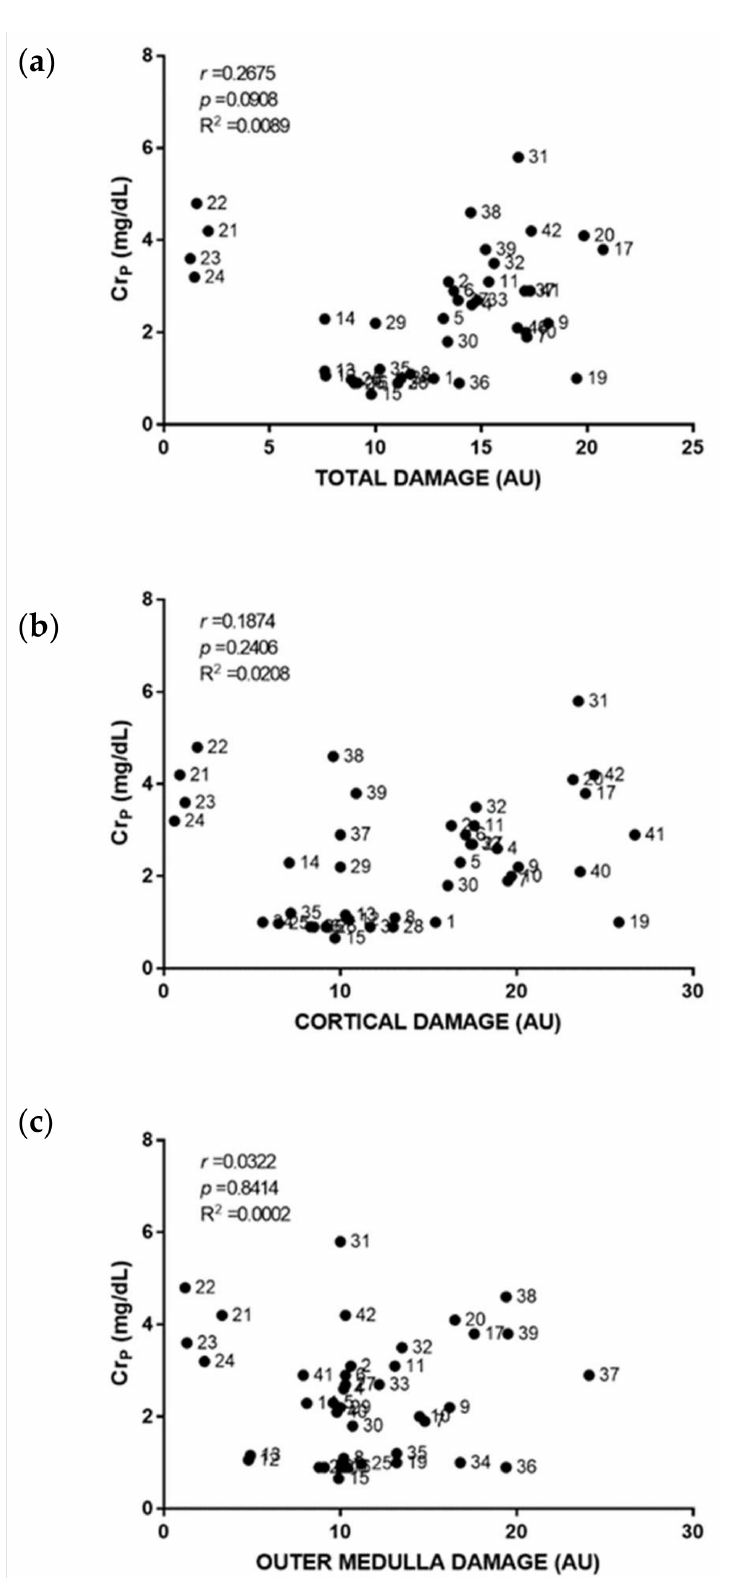
Figure 3. Plasma creatinine to renal damage relationship. Scatter plots showing the relationship between plasma creatinine concentration (Cr p ) with overall renal tissue damage ( a ), renal cortical damage ( b ), and outer medullary damage ( c ) of individual rats. AU: arbitrary units. p : Spear- man’s correlation p -value. r : Spearman’s correlation coefficient. R 2 : linear regression coefficient of